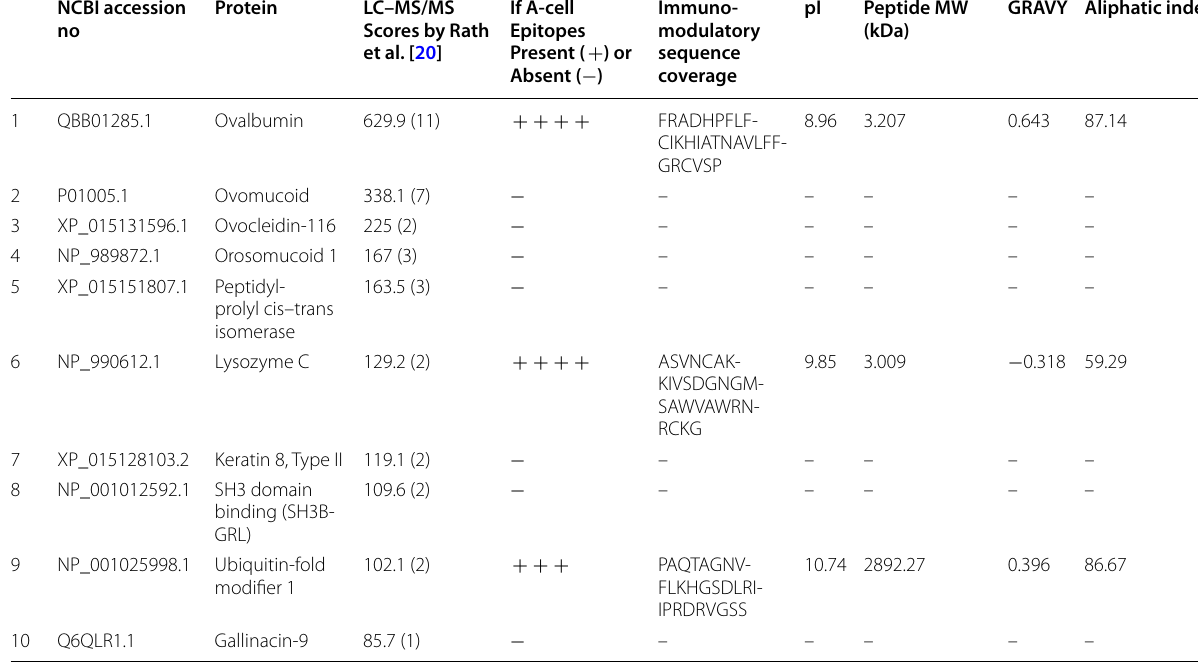
The number parenthesis is the number of peptides obtain inthe LC–MS/MS analysis as conducted by Rath et al. [13]. The number of ‘ of A-cell epitope in each IM protein as predicted by